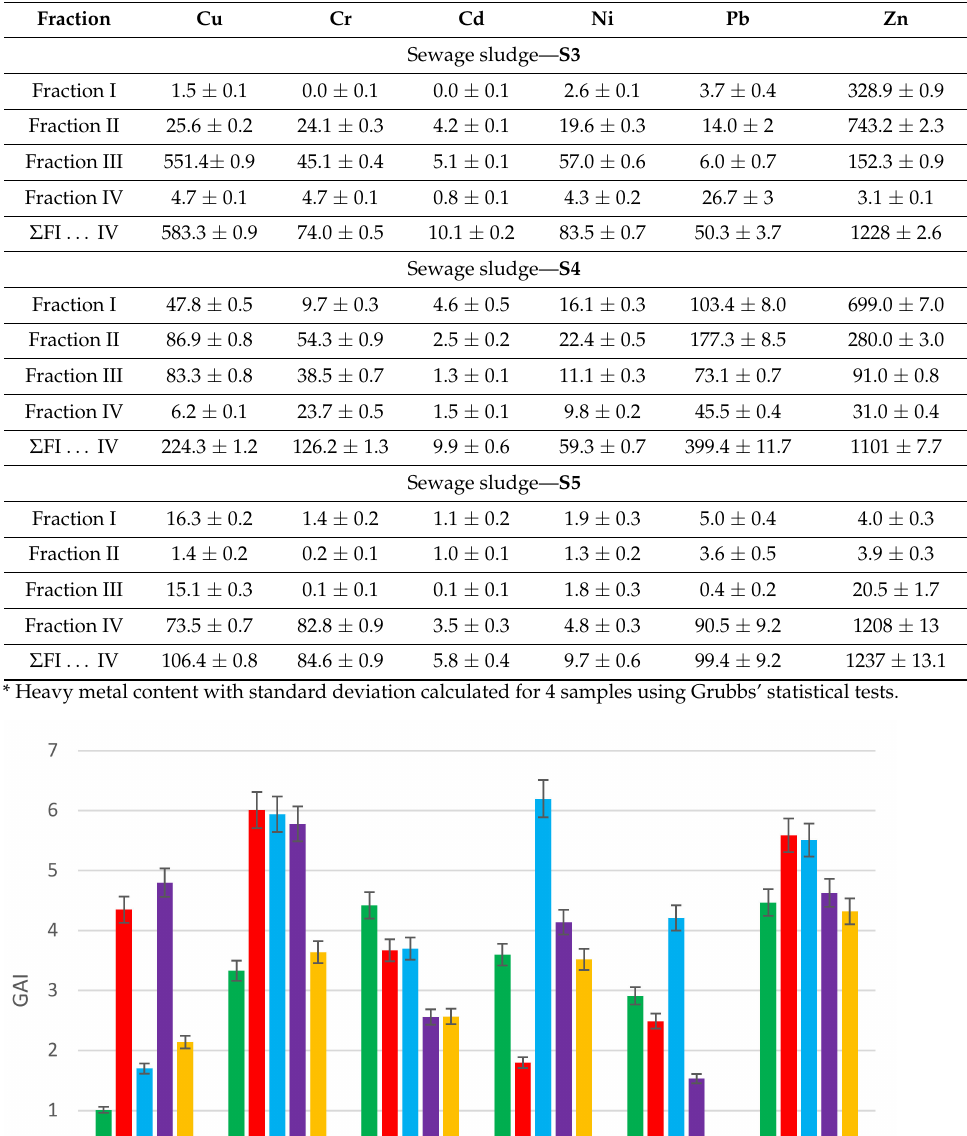
Heavy Metal (mg/kg s.m.)